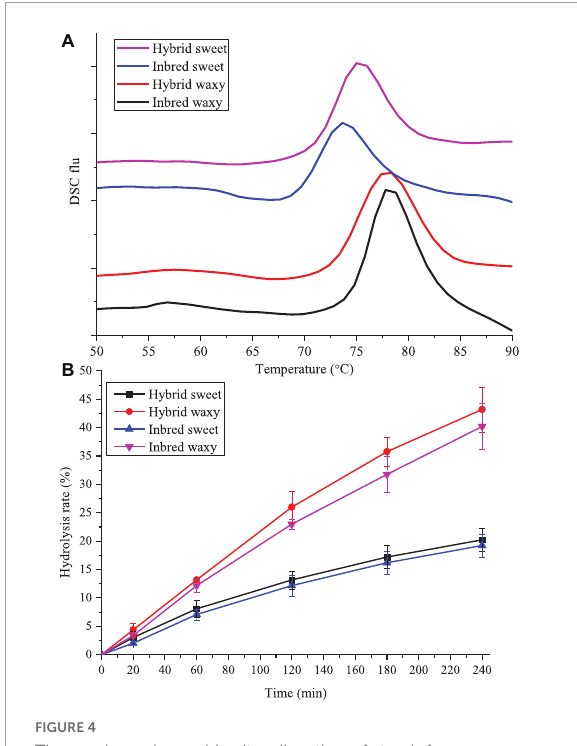
FIGURE4 Thermodynamics and in vitro digestion of starch from waxy, sweet, and hybrid sorghum. (A) DSC; (B) In vitro digestion.